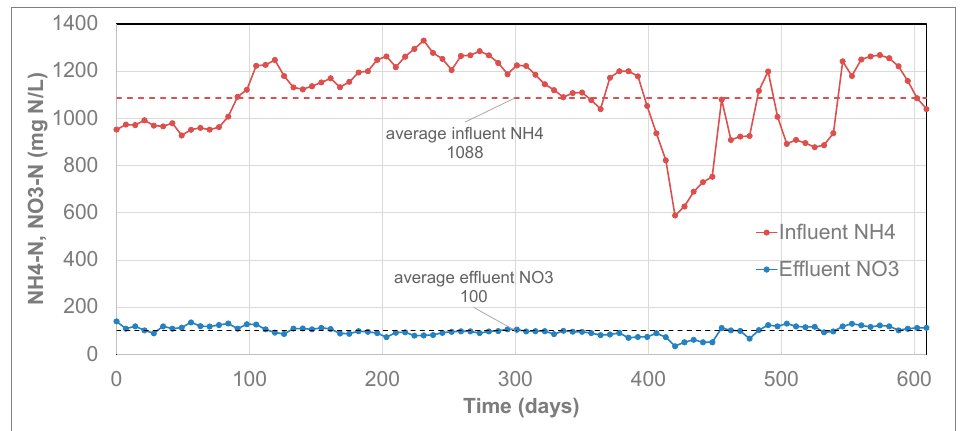
Figure 9. Influent ammonium and effluent nitrate from the Anammox reactor. Each data point represents the week average values for influent NH 4 -N or effluent NO 3 -N. The horizontal dashed lines show the average values of influent NH 4 -N and effluent NO 3 -N in the presented period. The average effluent ammonium in this period was 79 mg NH 4 -N/L (not shown in the graph).